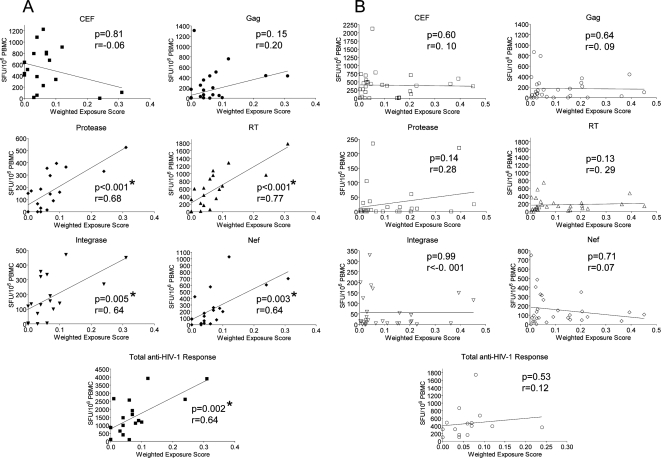
Correlations of exposure to a partner's HIV-1 and T cell IFN-γ response.IFN-γ T cell responses from the viremic partner (VP) group (A), or non-viremic partner (NVP) group (B), were plotted against the corresponding exposure scores against the peptide pools derived from CEF, or HIV-1 proteins Gag, Protease, RT, Integrase, and Nef. The cumulative anti-HIV-1 T cell IFN-γ response was also plotted. Significant correlations (denoted by *) were determined by two-tailed nonparametric spearmans correlation, spearman r (r), and linear regression analysis was plotted as a straight line.